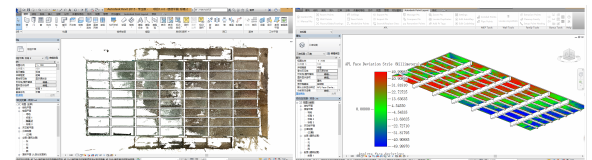
Figure 9. Modeling the beam system in BIM based on point clouds and analyzing their deviation